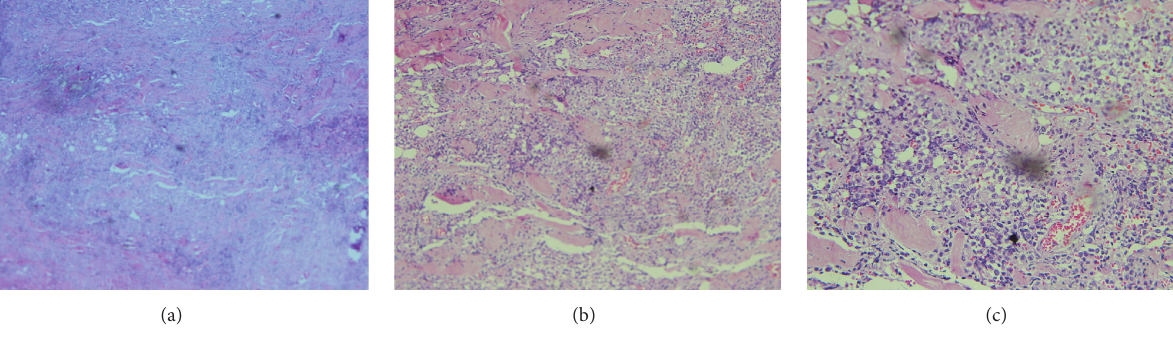
described the first case of isolated laryngeal LCH in 1970 [7, 8]. Duynstee et al. reported a case of isolated LCH in a 9-year-old girl who was presented with subglottic stenosis